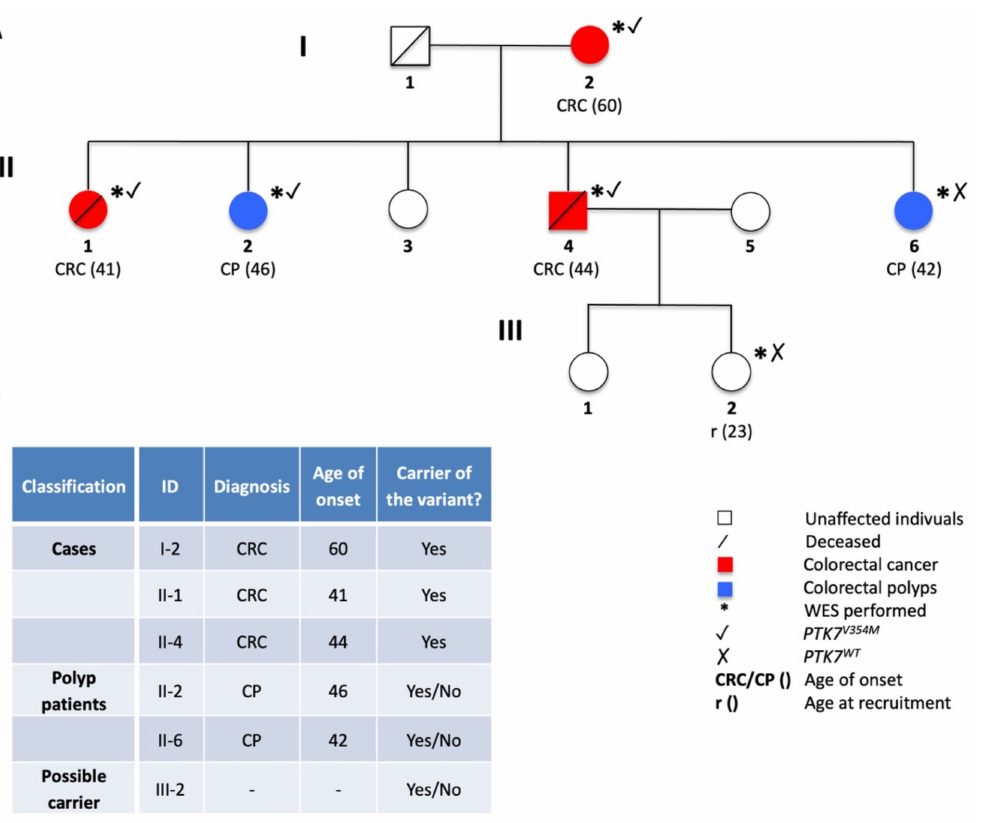
Figure 5. ( A ) The pedigree of the CRC-affected family carrying the PTK7 V354M variant. ( B ) Tabular summary of family members including personal data and the carrier status of the cancer-causing mutation. CRC—colorectal cancer, CP—colorectal polyps, WES—whole-exome sequencing, r—recruitment